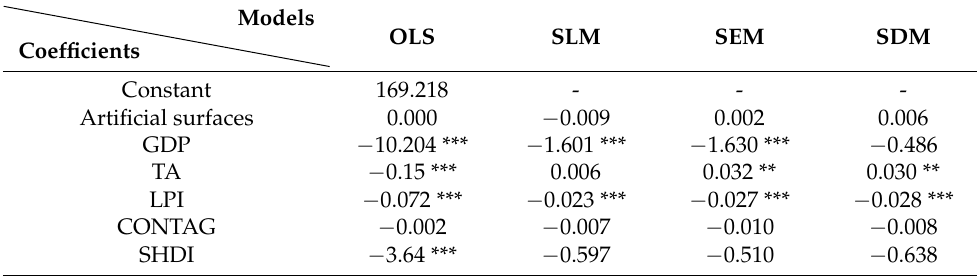
Table 3. Regression analysis of PM 2.5 concentration (dependent variable) and landscape indexes, GDP, artificial